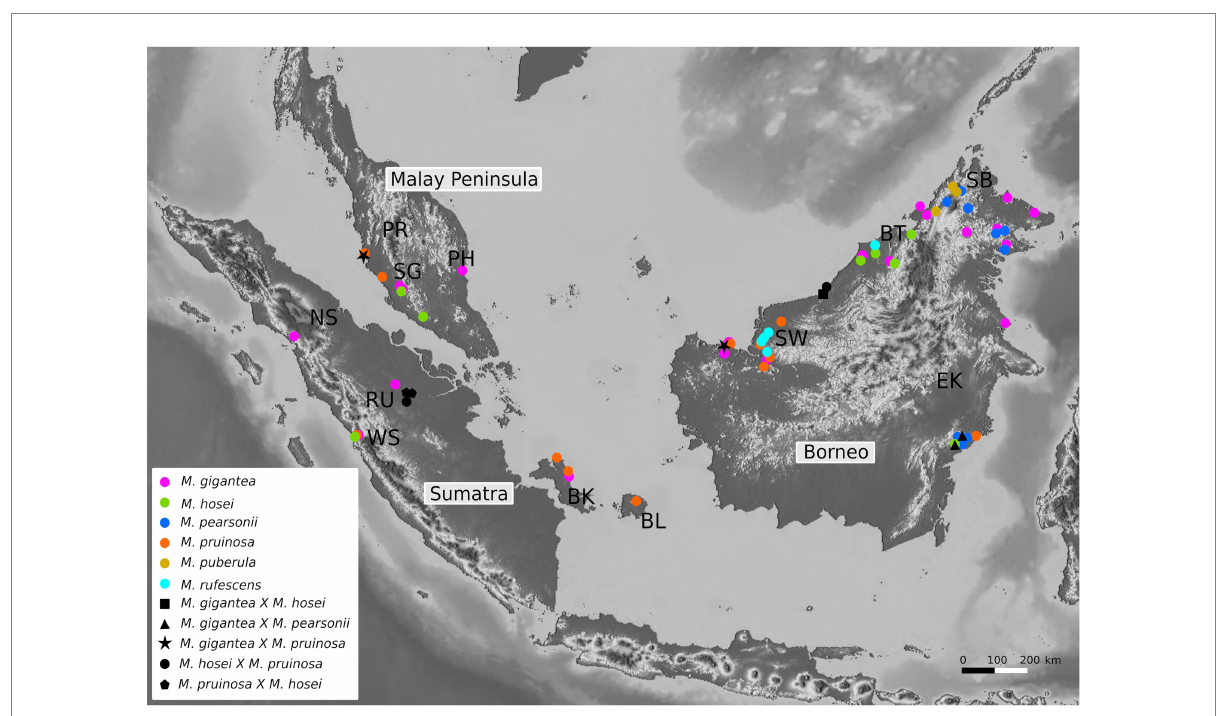
FIGURE 1 Specimen distribution map for 72 Pruinosae individuals included in the GBS analysis. Major regions or provinces wherefrom the individuals were collected are indicated as abbreviations: BK, Bangka; BL, Belitung; BT, Belait (Brunei); EK, East Kalimantan; NS, North Sumatra; PH, Pahang; PR, Perak; RU, Riau; SB, Sabah; SG, Selangor; SW, Sarawak; WS, West